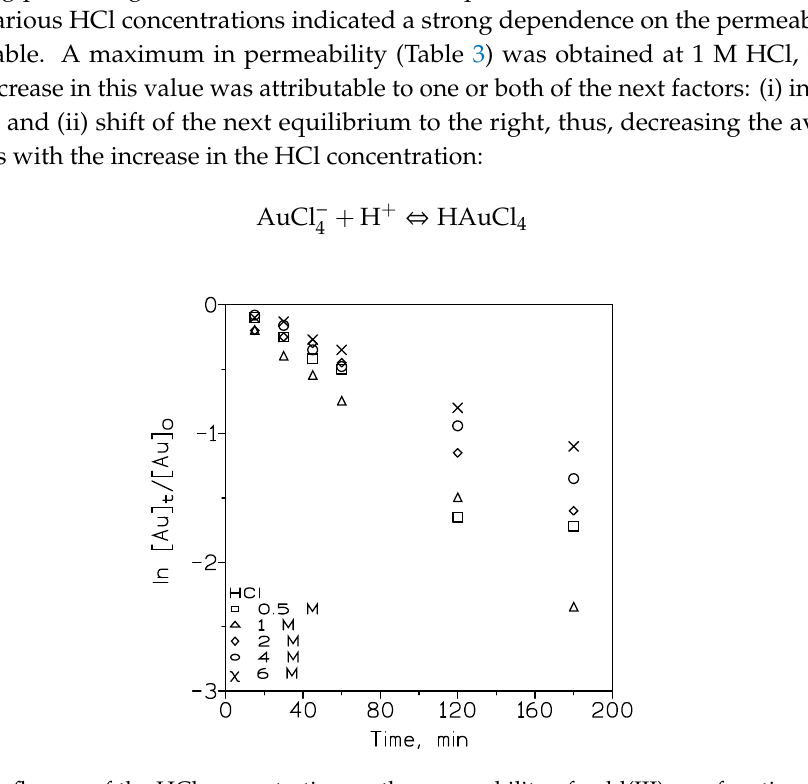
Table 3. Gold(III) permeabilities at various HCl concentrations in the feed phase.